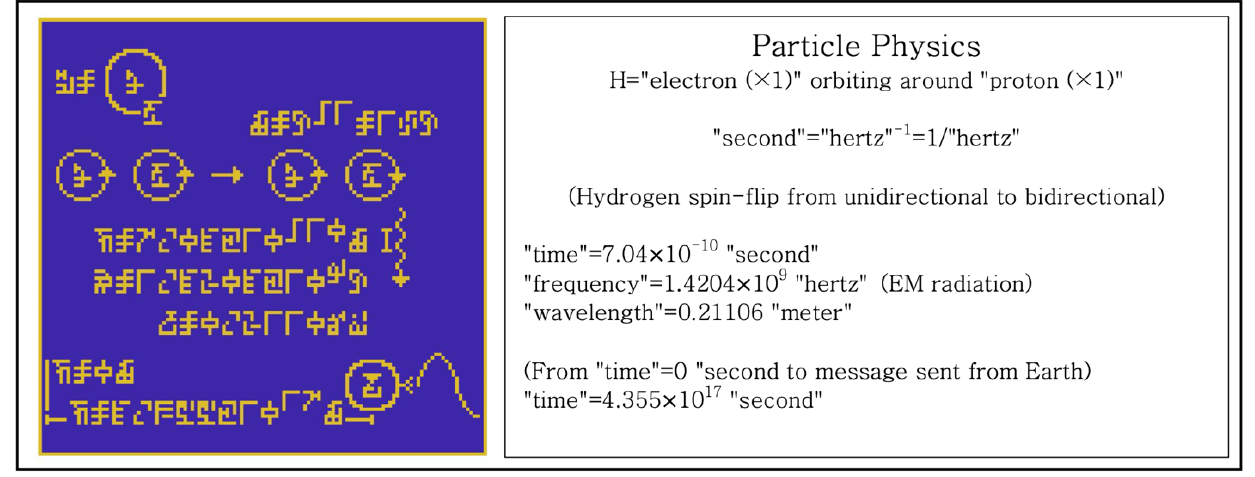
Figure 11. Hydrogen spectrum and hydrogen atom spin-flip transition in message, Page 5.